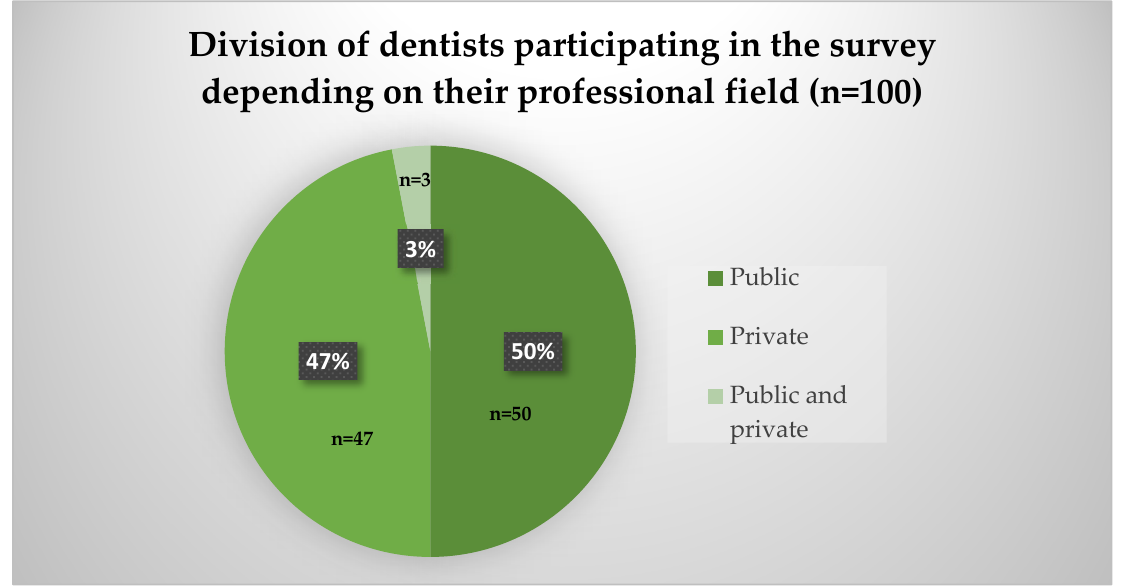
Figure 3. Division of dentists participating in the survey depending on their professional field .